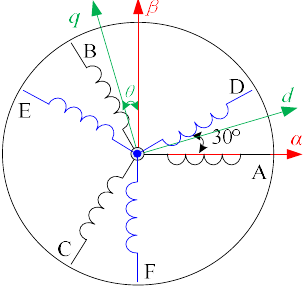
Figure 1. Winding structure of DTP-PMSM.